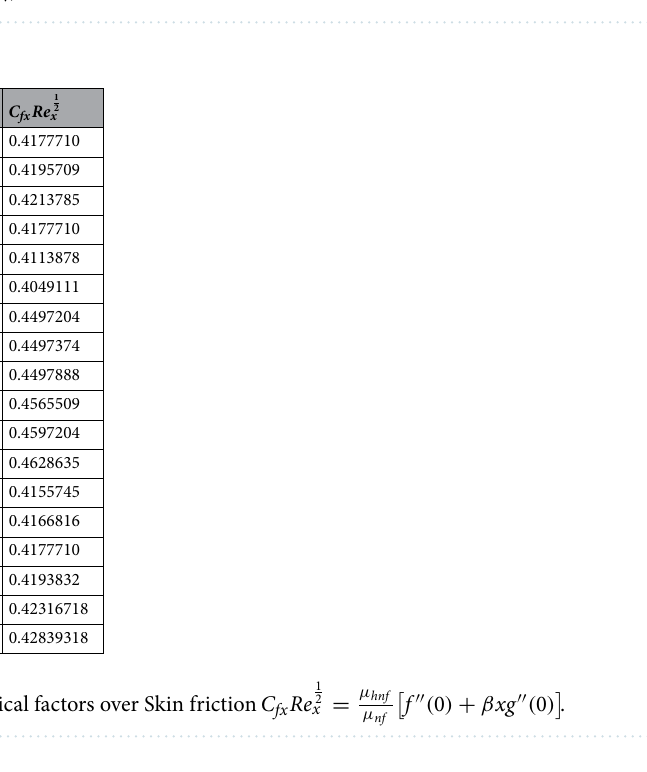
Figure 11. Influence of φ 1 , φ 2 on θ(η) for R = 0.3, Pr = 10.2 .